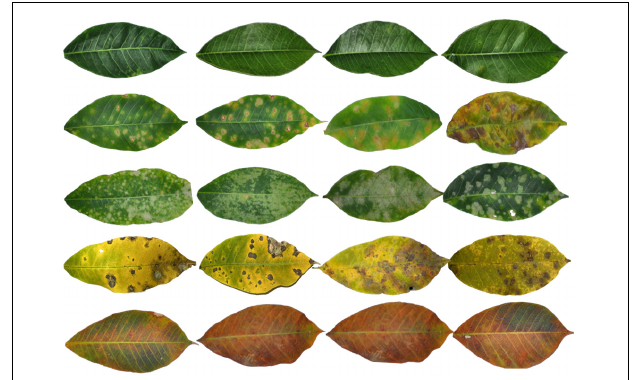
FIGURE 1 | Sample images of our constructed rubber dataset, from top to bottom, are healthy leaves, powdery mildew disease, rubber tree anthracnose, periconla leaf spot disease, and abnormal leaf fall